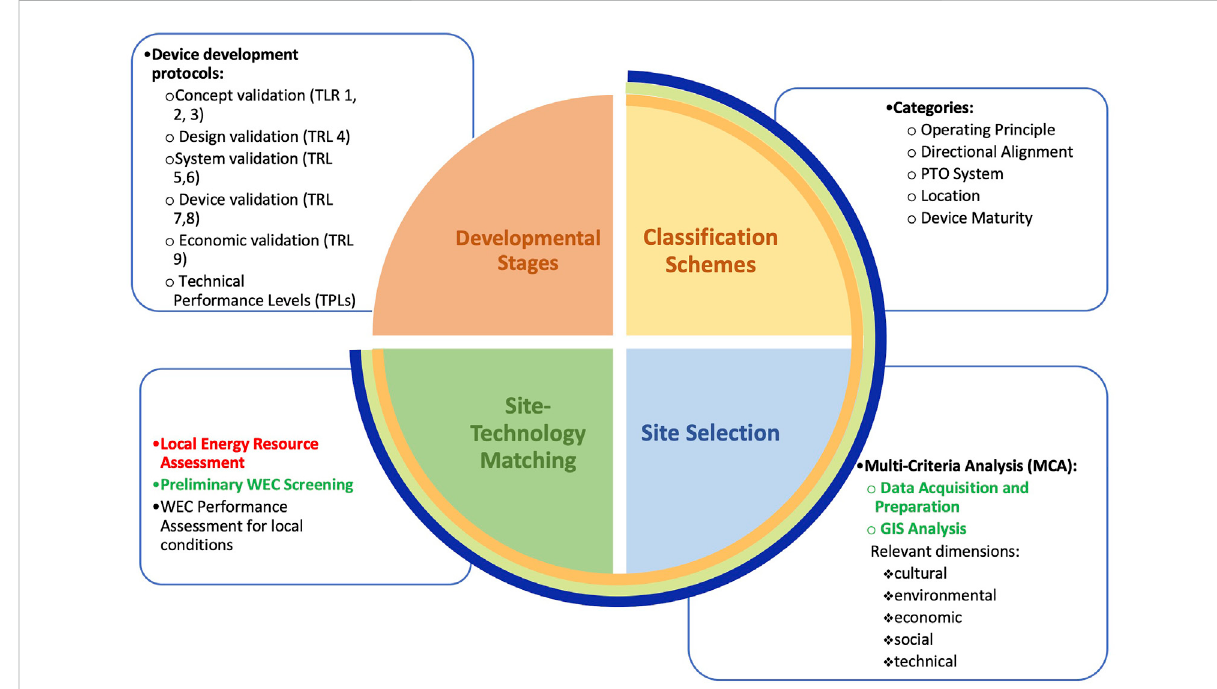
FIGURE 1 Schematic representation of the recommended systematic approach to the deployment of WECs in marine areas. Developmental stages are de fi ned according to functional readiness, as established by the International Structured Development Plan of the International Energy Agency – Ocean Energy Systems (IEA – OES) group (Holmes and Nielsen, 2010). The complementary Technical Performance Levels (TPLs - Weber, 2012) are included in the list, despite their limited applicability, due to the dif fi culty of generally assessing supplementary cost drivers which are better evaluated in the context of site-speci fi c implementation and are, in fact, usually covered within the site selection and site-technology matching components (e.g., environmental, social and legal acceptability, ef fi ciency, survivability, capital expenditure and lifecycle operational costs). An alternative classi fi cation of WEC TRLs can be found in Fitzgerald and Bolund (2012), who also recommend accounting for lifecycle readiness. Classi fi cation schemes are based on the categories de fi ned by Lehmann et al. (2017). The three bands in the Blue Deal logo colours encompass the components that have been addressed during the project lifetime, following the indications of the Blue Deal Methodology (Pulselli et al., 2022). The local resource assessment activities that are the object of this paper fall into the site-technology matching component, and are highlighted in red. They rely on results obtained in parallel project tasks (in green). Preliminary WEC screening made in its turn use of the device classi fi cation that was carried out during the project, allowing to narrow the number of promising technologies to those that can be effectively deployed in the Mediterranean